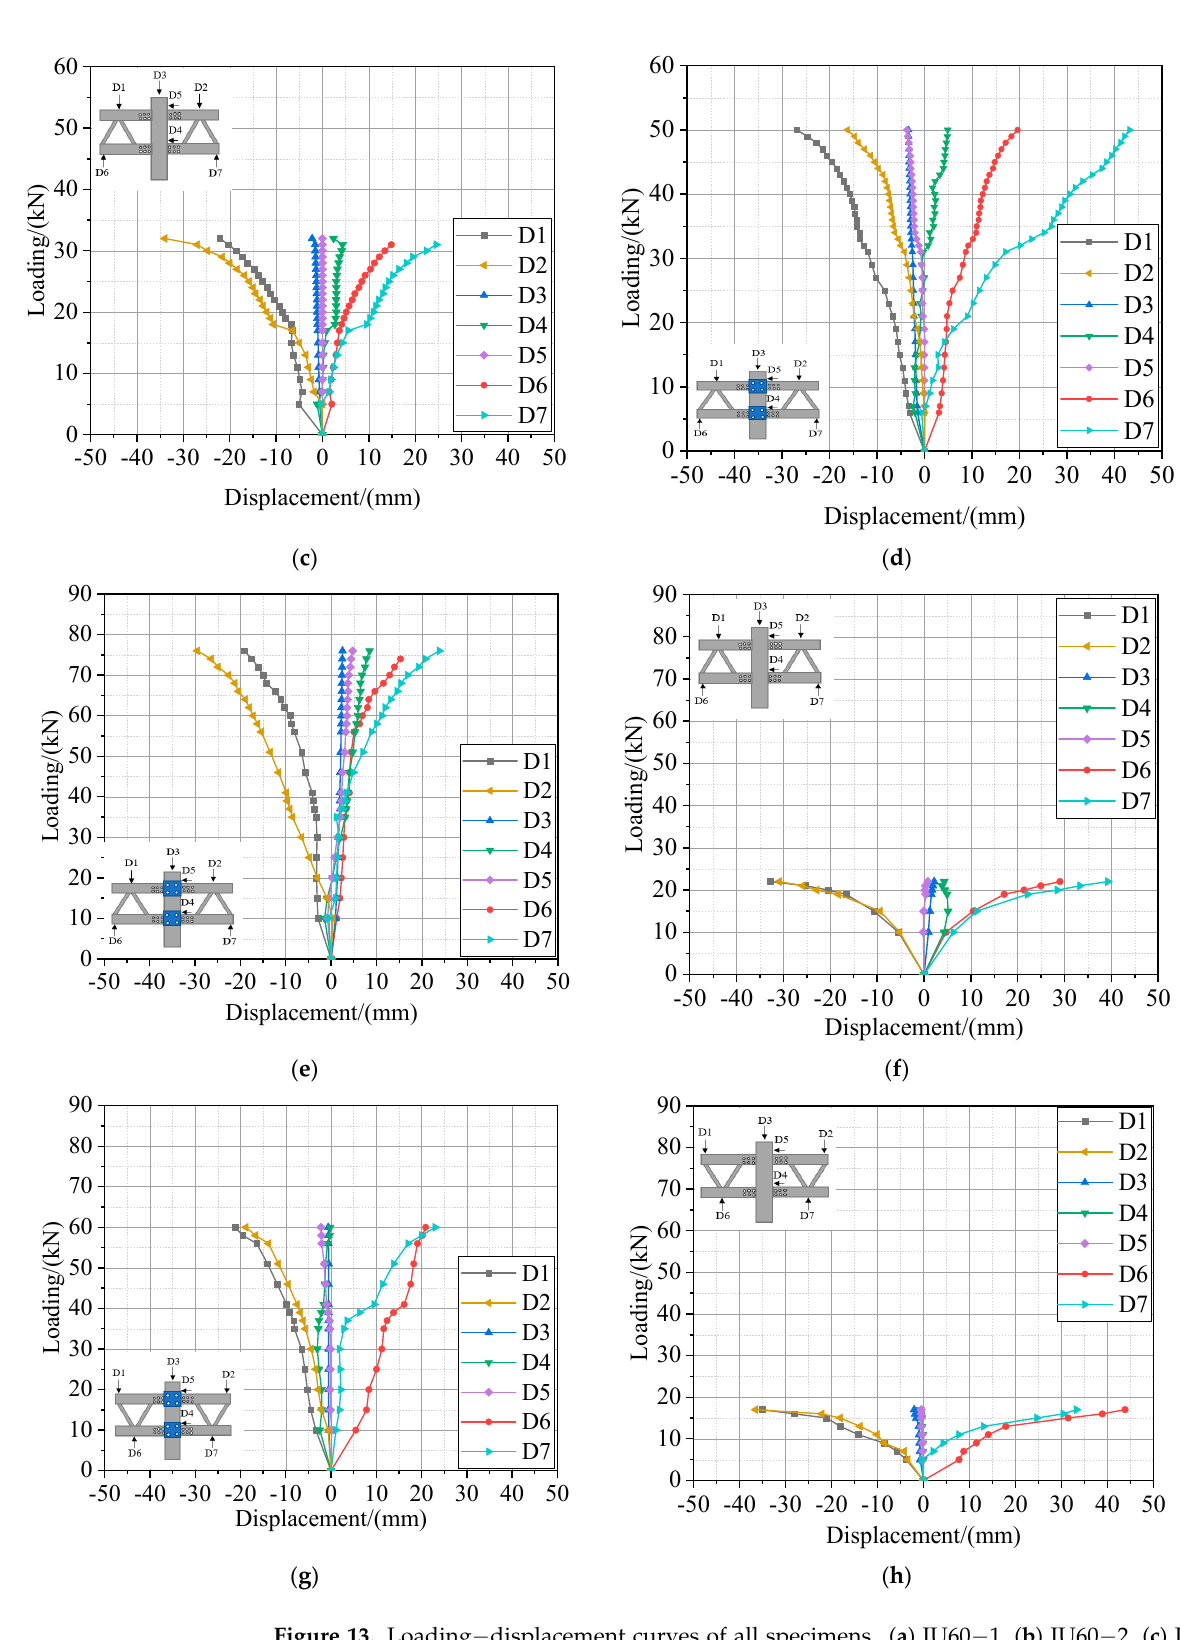
Figure 13. Loading − displacement curves of all specimens. ( a ) JU60 − 1, ( b ) JU60 − 2, ( c ) JU60 − 3, ( d ) JU60 − 4, ( e ) JU100 − 1, ( f ) JU100 − 2, ( g ) JU100 − 3, ( h ) JU100 − 4.